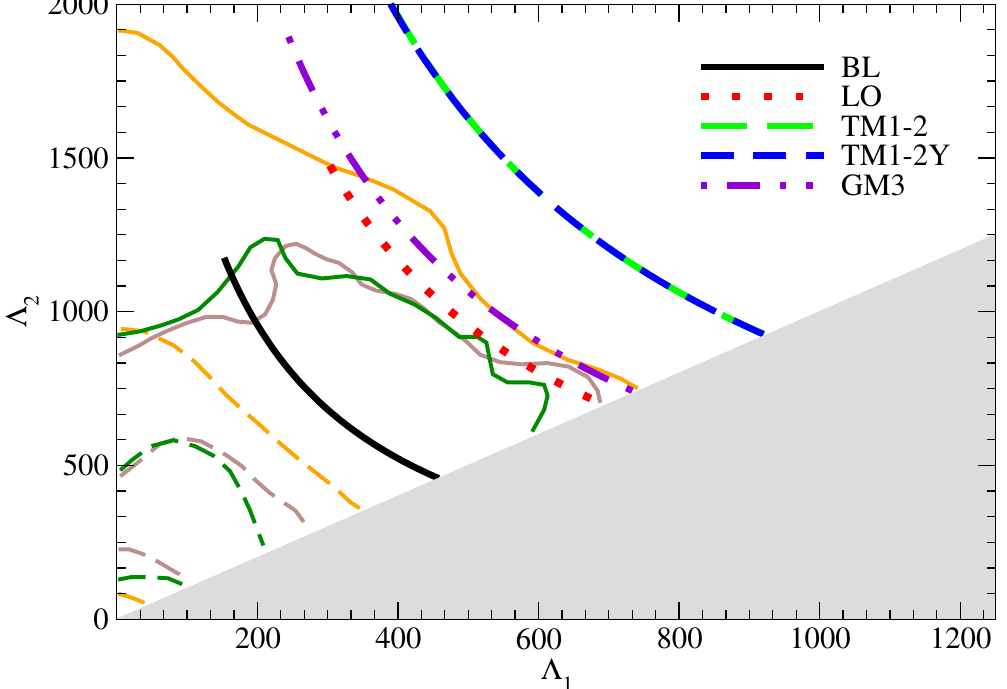
Figure 3. (Color online) Tidal deformabilities Λ 1 , Λ 2 of the two merging neutron stars for the EOS models adopted in the present work. The dark green, brown, and orange lines, taken from Reference [53], denote 50% (dashed) and 90% (solid) credible levels for the posteriors obtained using EOS-insensitive relations, a parameterized EOS without a maximum mass requirement,